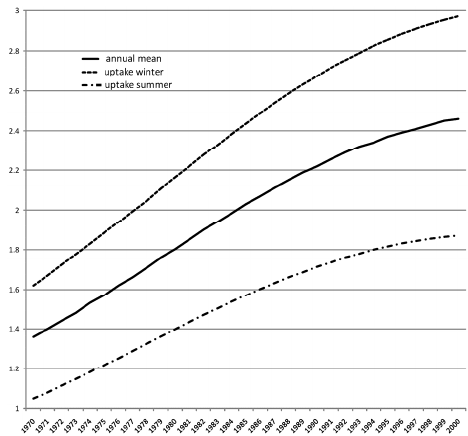
Figure 5: Integrated anthropogenic global CO 2 uptake (in PgC yr ‐ 1 ) for annual mean fluxes (plain line), 457 Fig. 5. Integrated anthropogenic global CO 2 uptake (in PgCyr − 1 ) winter fluxes (dashed line), and summer fluxes (dashed dotted line). Summer (Winter) uptake is 458 for annual mean fluxes (plain line), winter fluxes (dashed line), and computed using the August (February) output north of 20°N, the February (August) output south of 20°S 459 and the annual mean outputs between 20°N and 20°S. 460 summer fluxes (dashed dotted line). Summer (Winter) uptake is computed using the August (February) output north of 20 ◦ N, the February (August) output south of 20 ◦ S and the annual mean out- puts between 20 ◦ N and 20 ◦